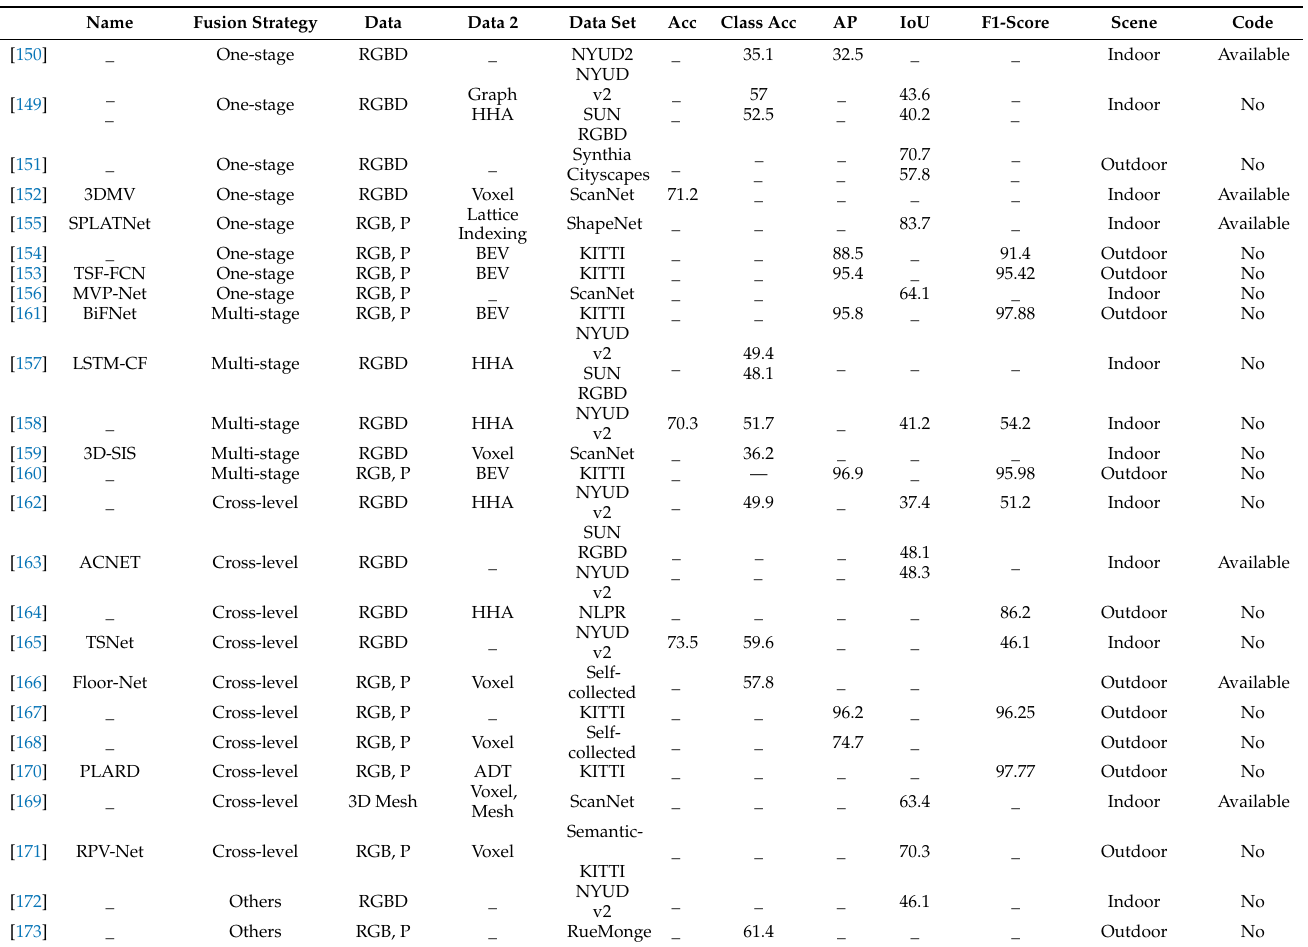
Table 8. Comparative summary of segmentation methods using feature-based fusion strategy (P: point cloud; Data 2: intermediate